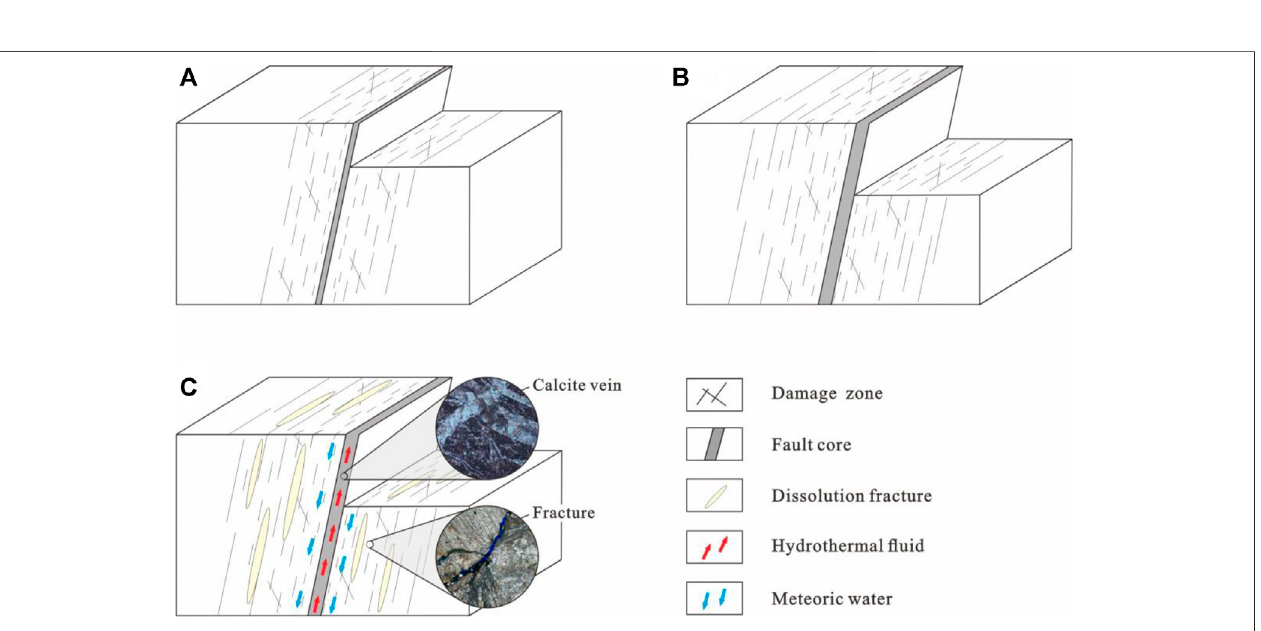
FIGURE 9 | | The evolution model of the reverse fault controlling the reservoir. (A) At the early stage of reverse fault formation, the fault core is narrow and the damagezoneofcertainwidthisdeveloped. (B) Bothfaultcoresanddamagezonesarefurtherwidenedtoformhighlypermeableformations. (C) Atmosphericwaterand hydrothermal fl uid enter the fault zone, in which the fault core with high permeability is mainly cemented by fl uid, and the damage zone forms dissolution fractures. It can be seen from the microstructure that the fault core is mainly cementation of non-cohesive breccia and calcite, and the damage zone is mainly developed by the